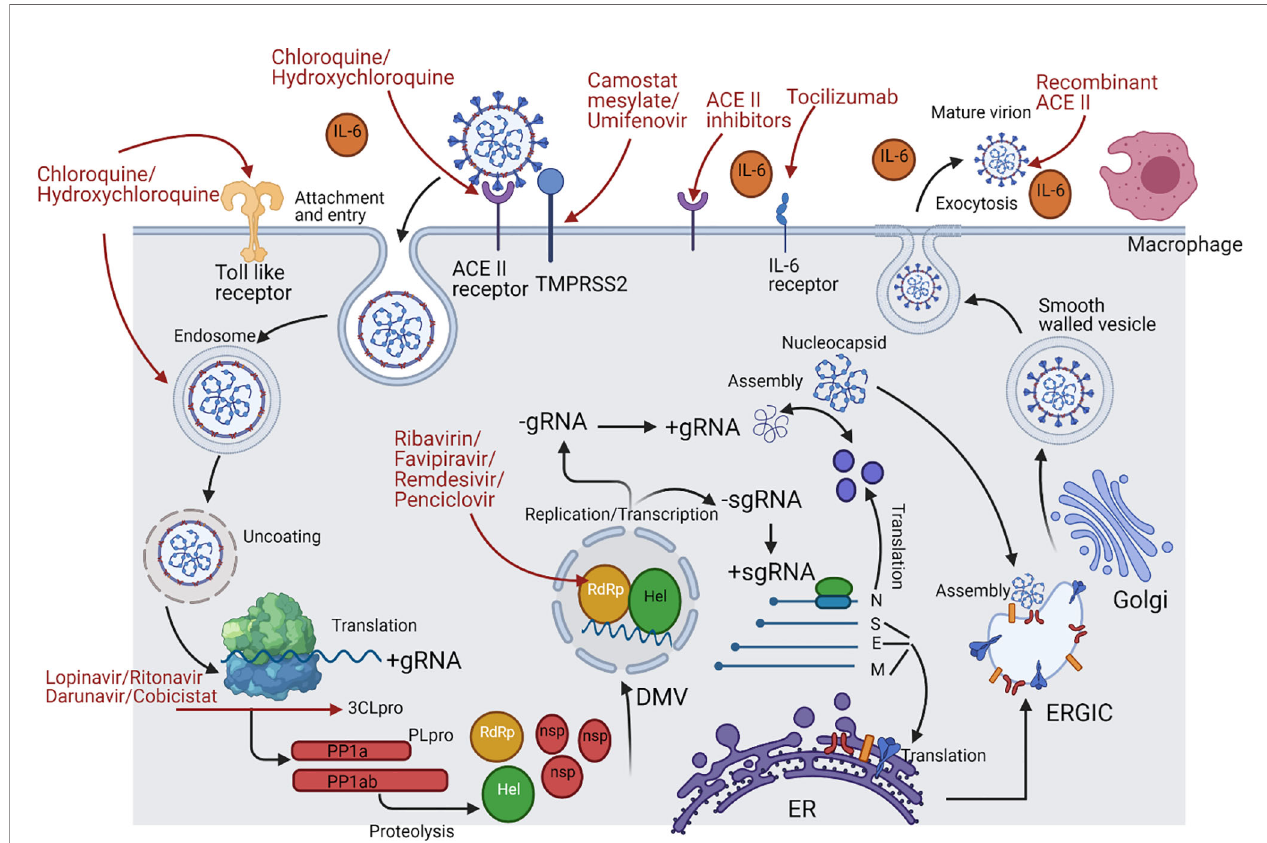
place. The polyproteins undergo cleavage by the viral proteases Papain like protease (PLpro) and Chemotrypsin like protease (3C like protease or 3CLpro or Mpro). Lopinavir/Ritonavir and Darunavir/Cobicistat are the ones used to inhibit 3CLpro. On the other hand, the transcription process start since the Replication/